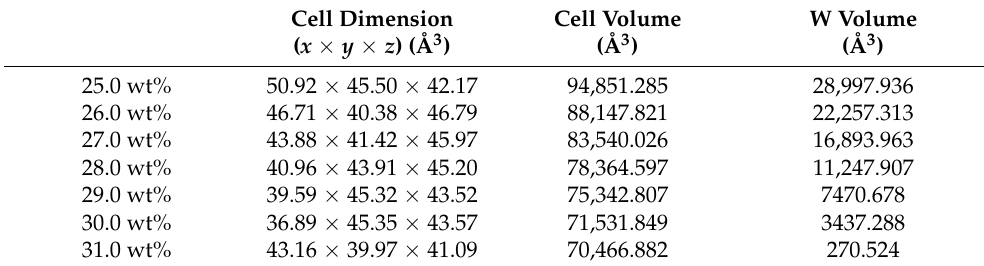
Table 2. Volume parameters of aluminum sol systems at 298 K.